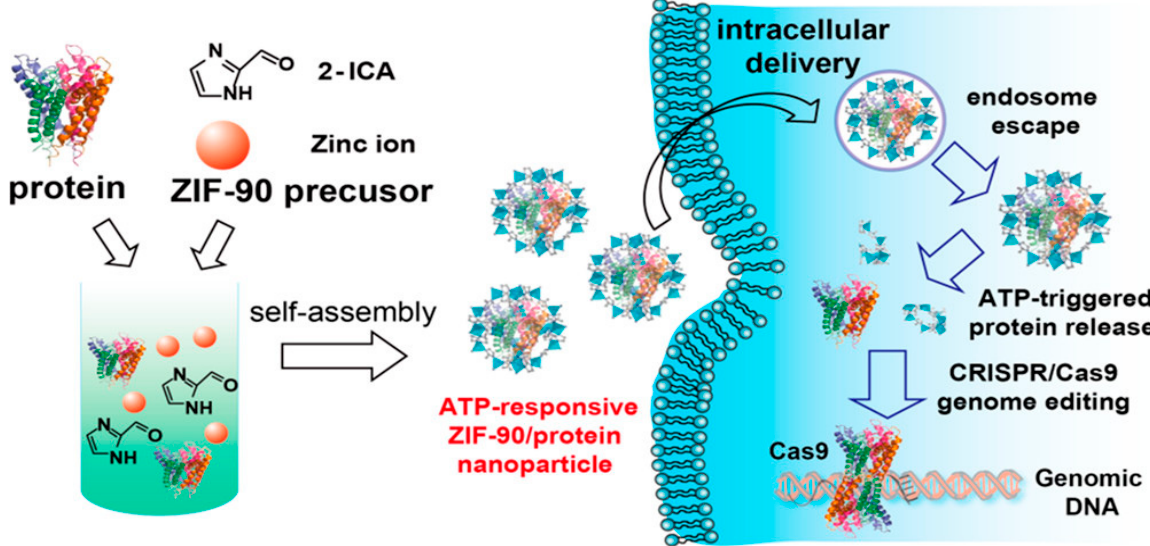
Figure 7. Metal–organic framework, ZIF-90 based ATP-responsive delivery of CRISPR/Cas9 machinery in the HeLa cells. Reprinted with permission from ref [58]. Copyright 2019, American Chemical Society.